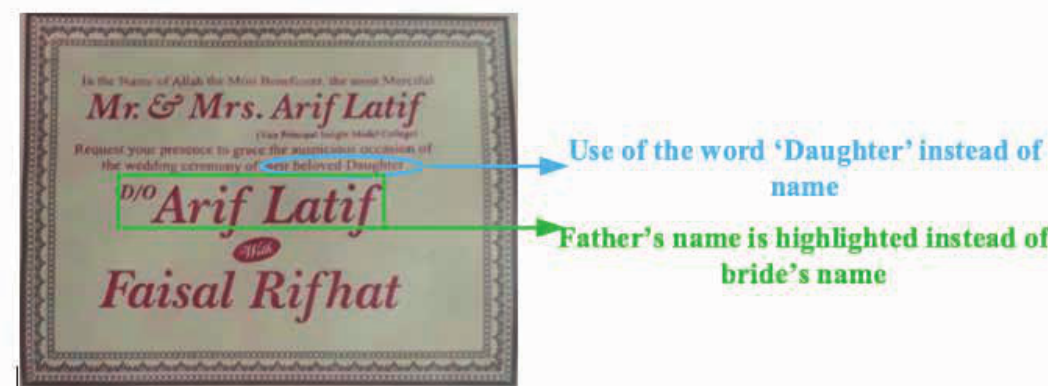
Figure 5: The naming convention of the bride